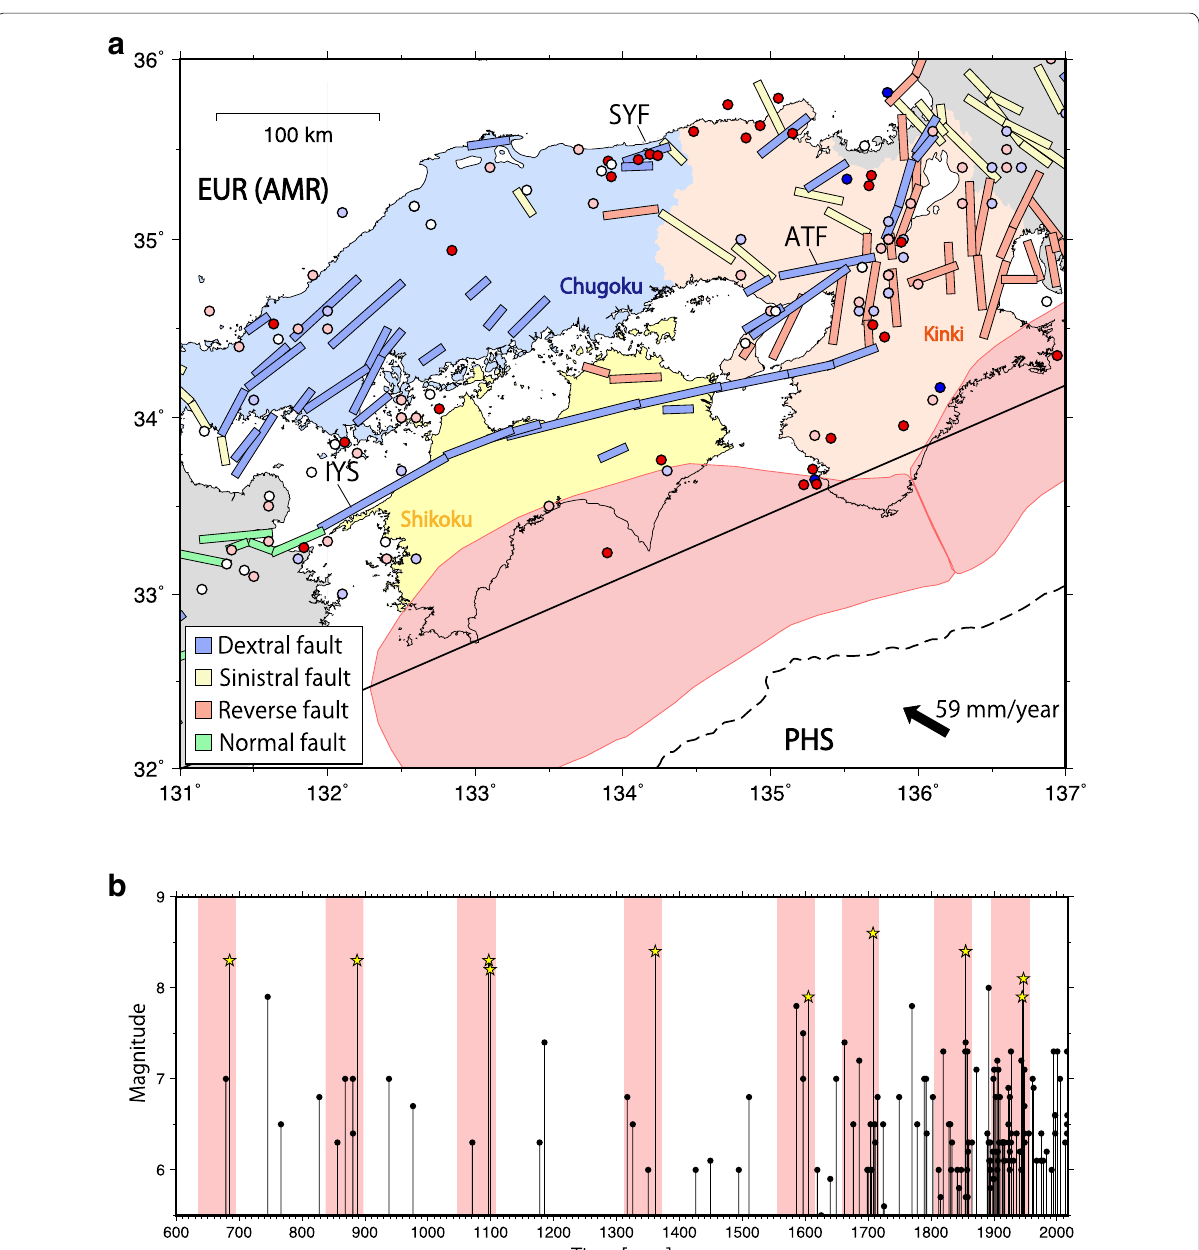
Fig. 1 Major active faults and seismic activity in southwest Japan between 679 and 2018: a distribution of the major active faults (Earthquake Research Committee 2018) and epicenters of the crustal earthquakes between 679 and 2018. The catalog of earthquakes from 679 to 1921 is based on Utsu (1990, 2002, 2004), whereas that from 1922 to 2018 is based on the Japan Meteorological Agency (JMA). The epicenters are plotted north of the black solid line in the range of a . The light and dark red circles indicate the epicenters of crustal earthquakes that occurred within 50 years before and 10 years after a megathrust earthquake. The light and dark blue circles indicate the epicenters in the other periods. The light and dark colored circles indicate the epicenters during 697–1921 and 1922–2018, respectively. The white circles indicate the epicenters after 1968. The black arrow denotes relative plate motion (DeMets et al. 2010). The red‑shaded areas are the source areas of the megathrust earthquake along the Nankai trough (Earthquake Research Committee 2001). EUR, AMR, PHS, ATF, SYF, and IYS are abbreviations for the Eurasia Plate, Amurian Plate, Philippine Sea Plate, Arima–Takatsuki Fault, Shikano–Yoshioka Fault, and the Iyonada segment of MTL, respectively), and b magnitude–time diagram of the crustal earthquakes shown in a . The yellow stars are the megathrust earthquakes. The red‑shaded areas indicate the periods 50 years before and 10 years after the megathrust earthquakes along the Nankai